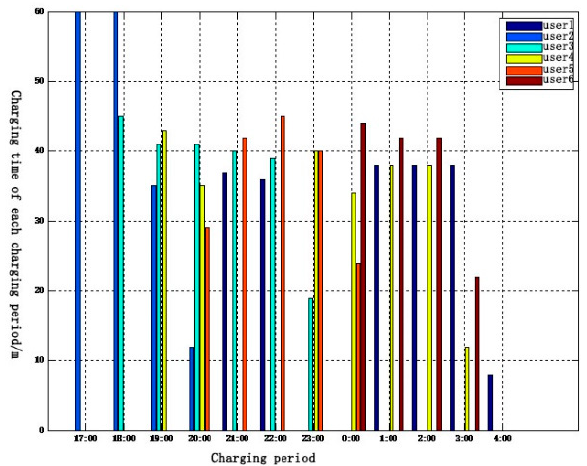
Figure 6. The result of the charging time of users in each charging period.